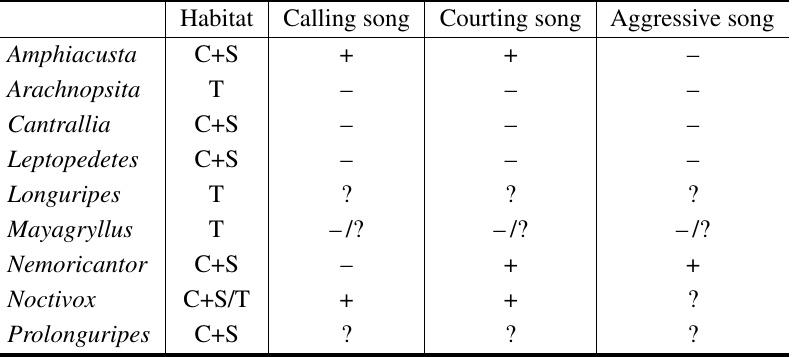
Habitat and acoustic characteristics in Amphiacustae crickets. After Desutter-Grandcolas (1993, 1997b, c). Abbreviations: C+S, cavicolous + straminicolous. T: troglobitic.